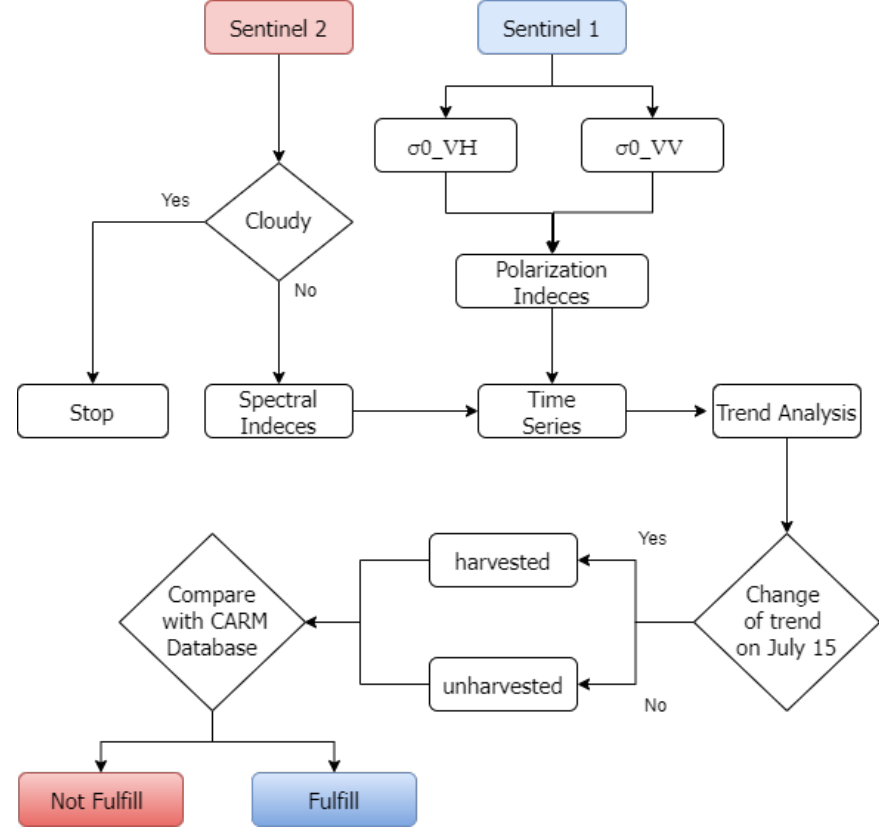
Figure 2. Planning according to decision